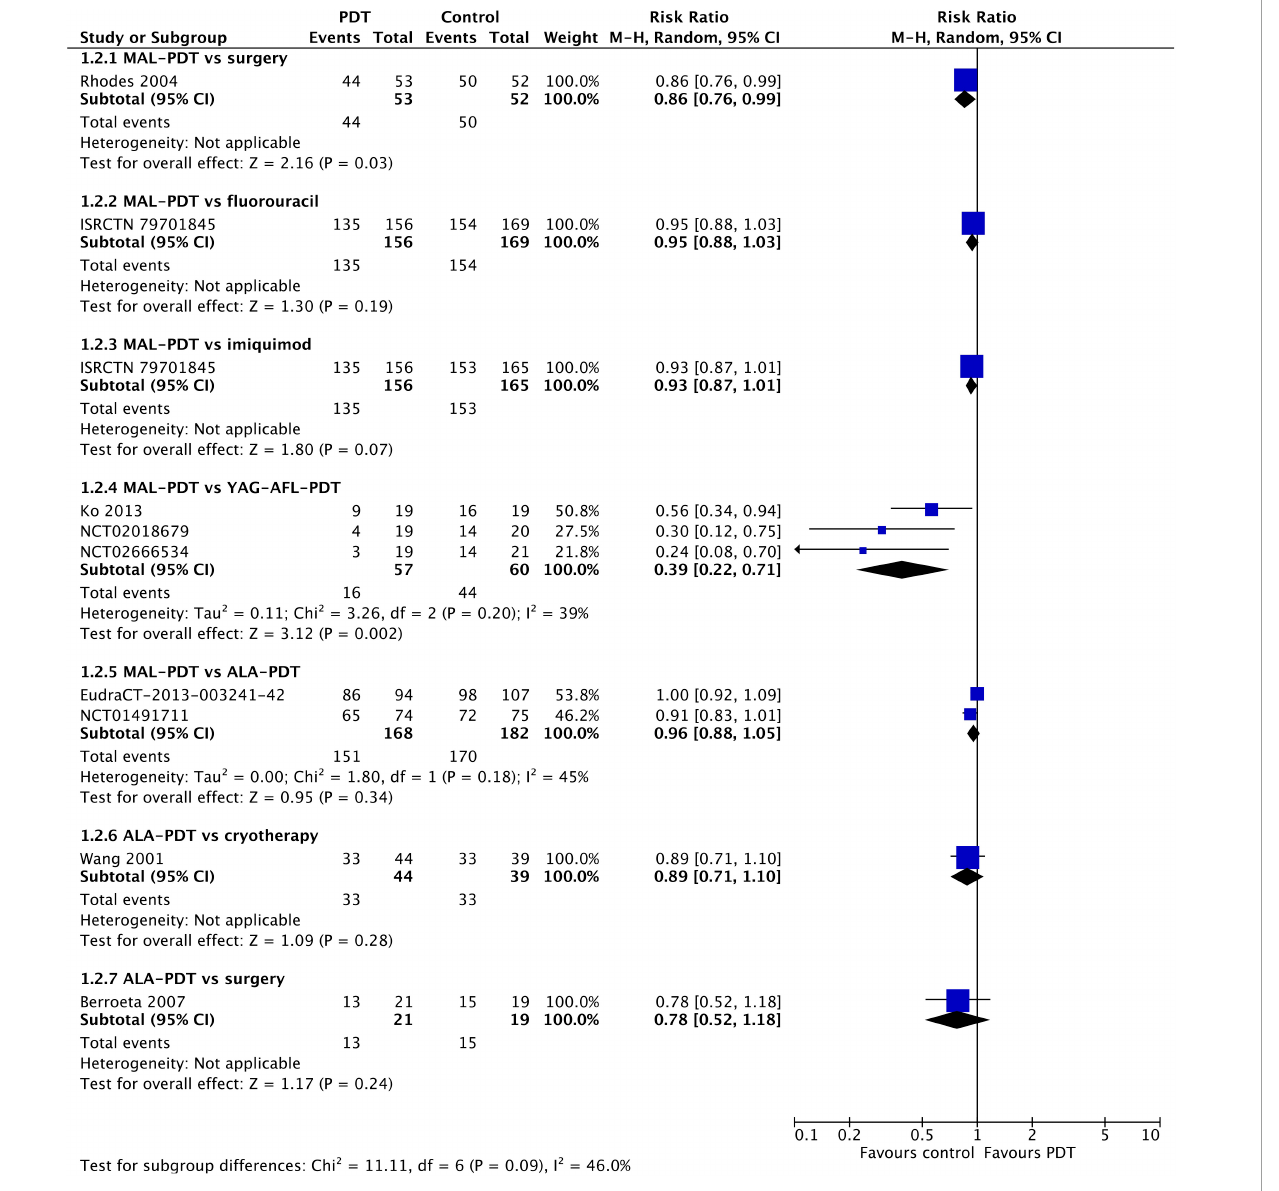
FIGURE3 Meta-analysis of the risk of response at 12 months post-treatment by comparator. Data are risk ratios with 95% confidence intervals.